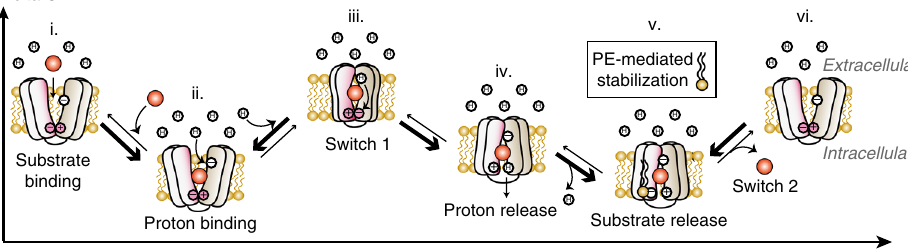
Fig. 7 A lipid-mediated mechanism of transport. Model of secondary transport based on the interaction between charge-relay networks of XylE and PE phospholipid (i) Substrate (orange) binds from the extracellular side and stabilizes the OF conformation. (ii) Proton binding triggers closure of the extracellular side. (iii) The fully loaded transporter transitions towards an occluded conformational intermediate. Proton translocates through the transporter to the conserved charge-relay networks (pink) on the intracellular side (iv) Disruption of the charge networks opens the intracellular side. Spontaneous deprotonation upon exposure to the slightly basic cytosol leads to intracellular proton release. (v) Direct interactions between PE and the transporter stabilize the inward-facing conformation, thus facilitating substrate release and completing the transport cycle. Reformation of the cytoplasmic charge-relay networks leads to the subsequent conformational switch. (vi) is equivalent to (i)